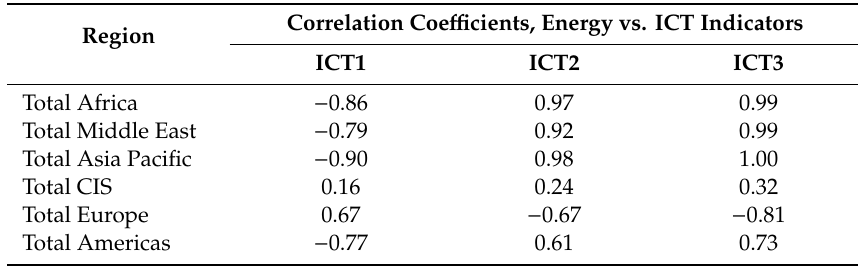
Table 5. Correlation matrix. Correlation Coe ffi cients, Energy vs. ICT Indicators Region ICT1 ICT2 ICT3 Total Africa − 0.86 0.97 0.99 Total Middle East − 0.79 0.92 0.99 Total Asia Pacific − 0.90 0.98 1.00 Total CIS 0.16 0.24 0.32 Total Europe 0.67 − 0.67 − 0.81 Total Americas − 0.77 0.61